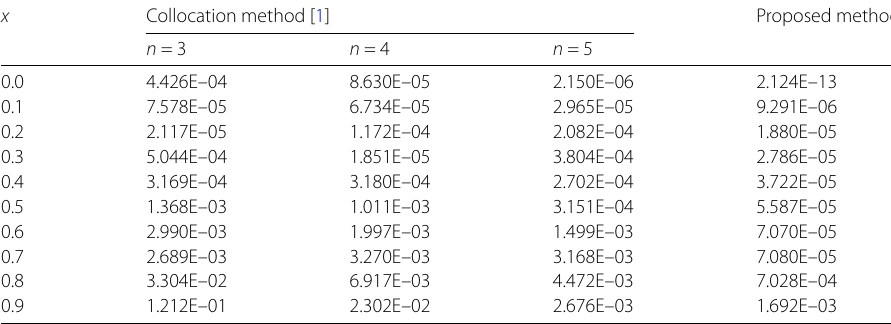
Table 10 A comparison of maximum absolute errors at T = 0.5 for Problem 4